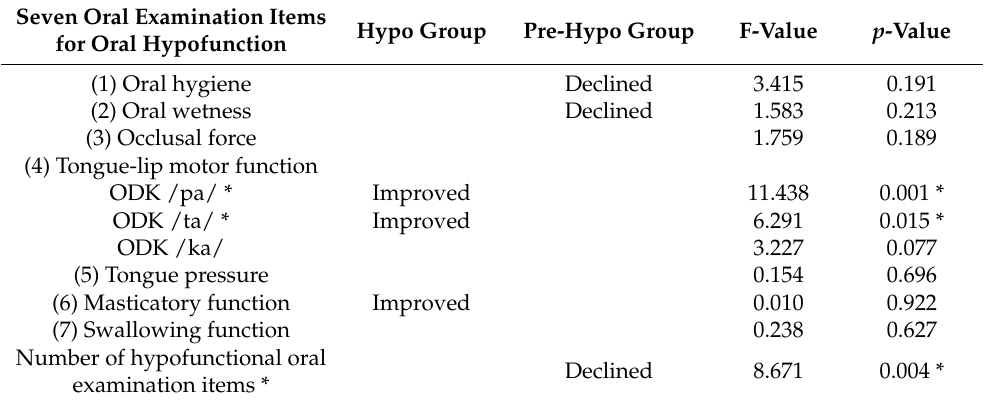
Table 4. Interaction effect in temporal changes of oral function between 1st and 2nd examination in the Hypo and Pre-hypo groups.